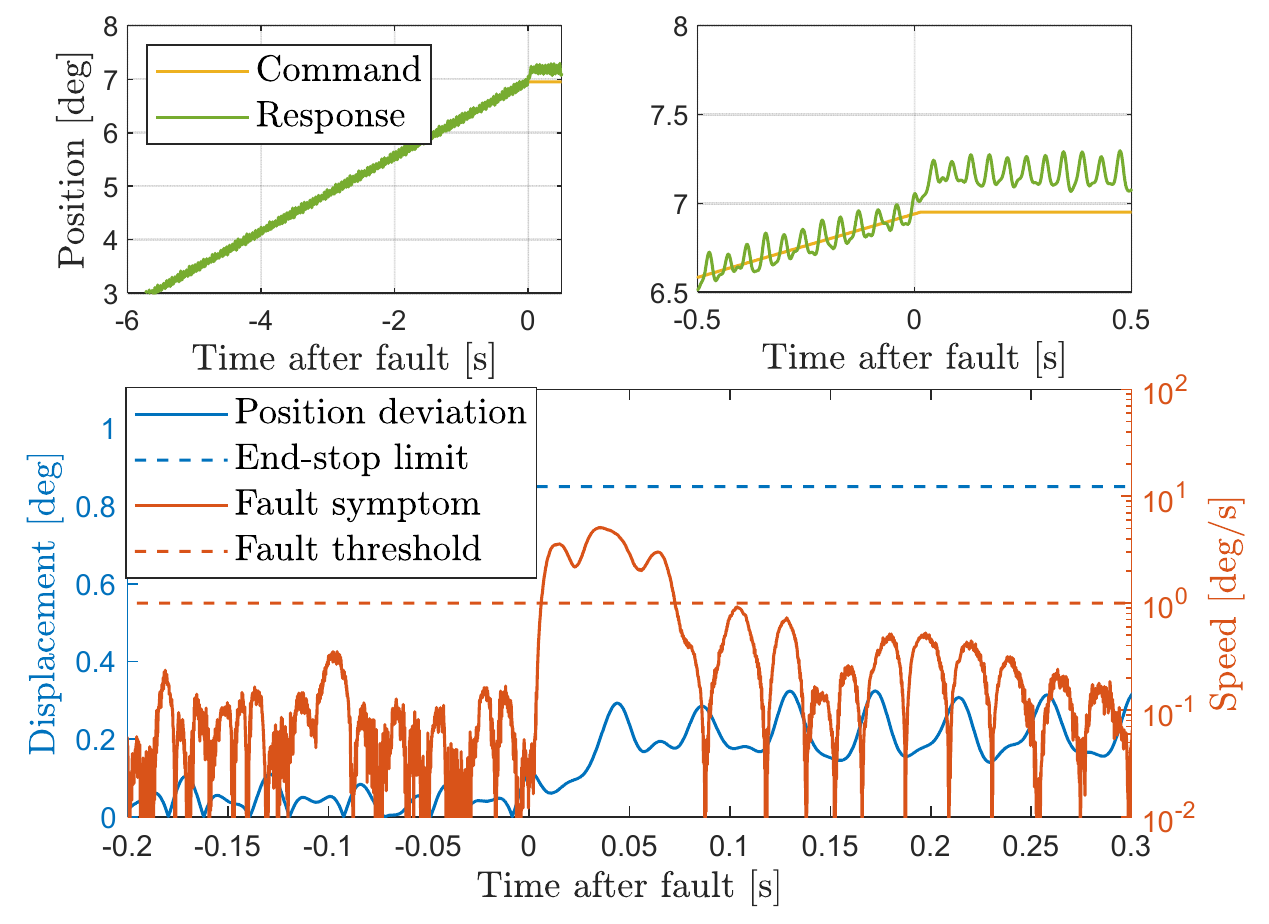
Figure 16. EMA failure transient with a control hardover fault with BEMF damper circuitry: simulation obtained with the experimentally validated model of the actuator ( t FI = 0 s; t FD = 13.4 ms; t FC = 64.4 ms).